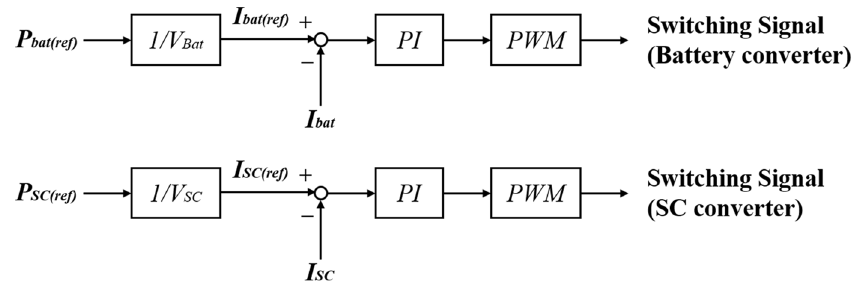
Figure 5. The current control loop for DC/DC converter.